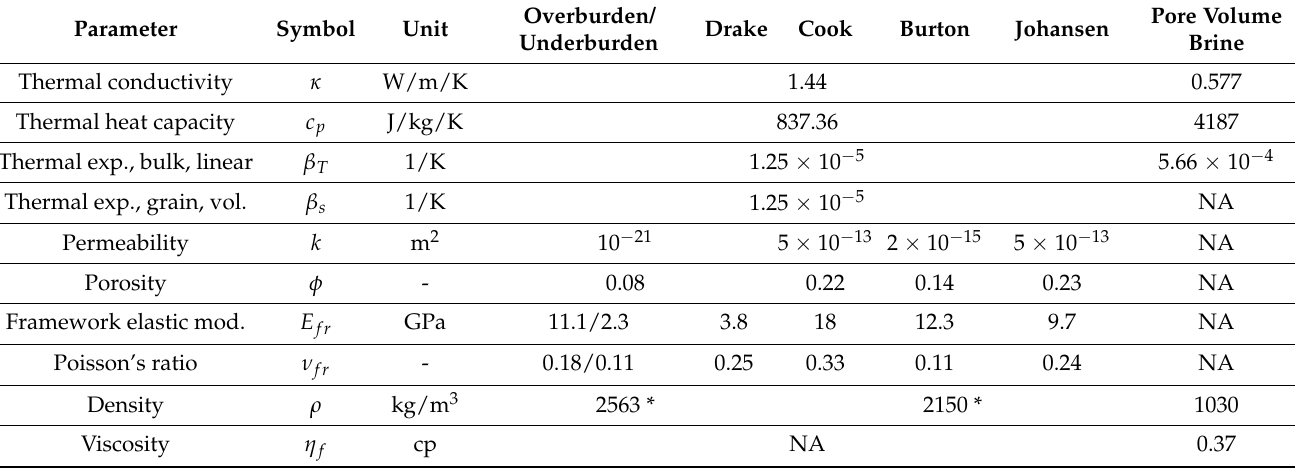
Table 2. Thermo-hydro-mechanical properties of the various formations in Figure 8 (geometry) and fluid. Parameter Symbol Unit